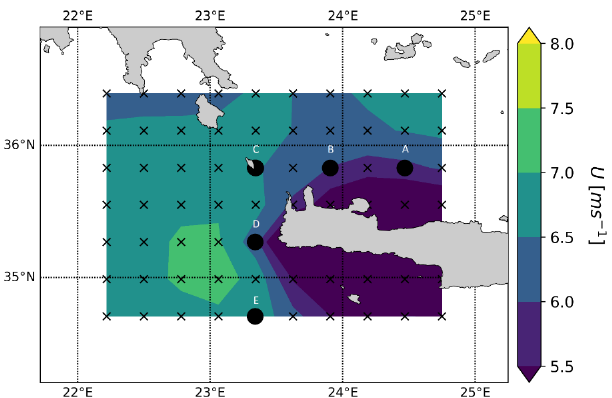
Figure 8. Mean wind speed (ms − 1) from ERA5 for 549 cases col- located with SAR scenes around Crete with points used for extract- ing wind speed and direction for classification. The five locations A to E are mentioned in the